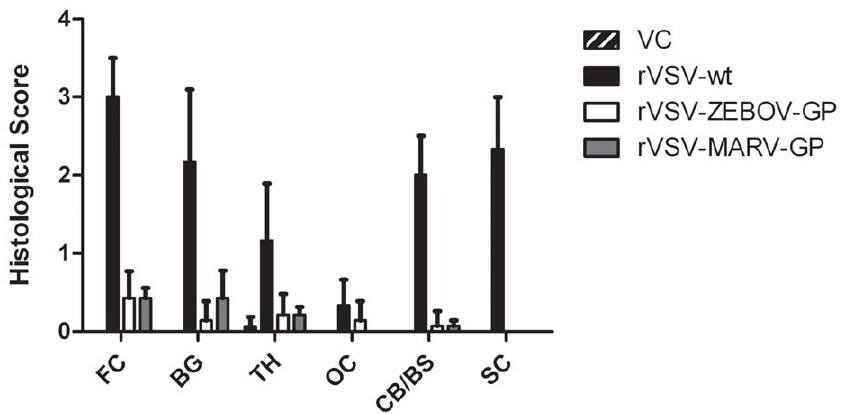
Figure 5. Combined histological scores of neural tissue. Graph displaying the mean histological values of the neural tissue from left and right hemisphere for the frontal cortex (FC), basal ganglia (BG), thalamus (TH), occipital cortex (OC), and cerebellum/brainstem (CB/BS), plus scores from the spinal cord (SC). Error bars, standard deviation. VC=vehicle control.